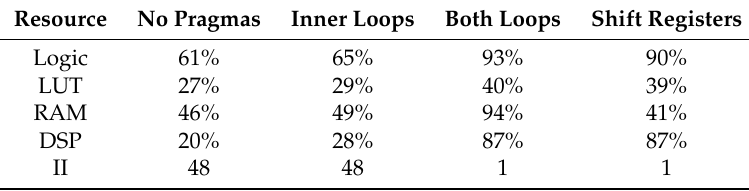
Table 3. Resource usage and maximum initiation interval (II) for various loop unroll pragmas in the